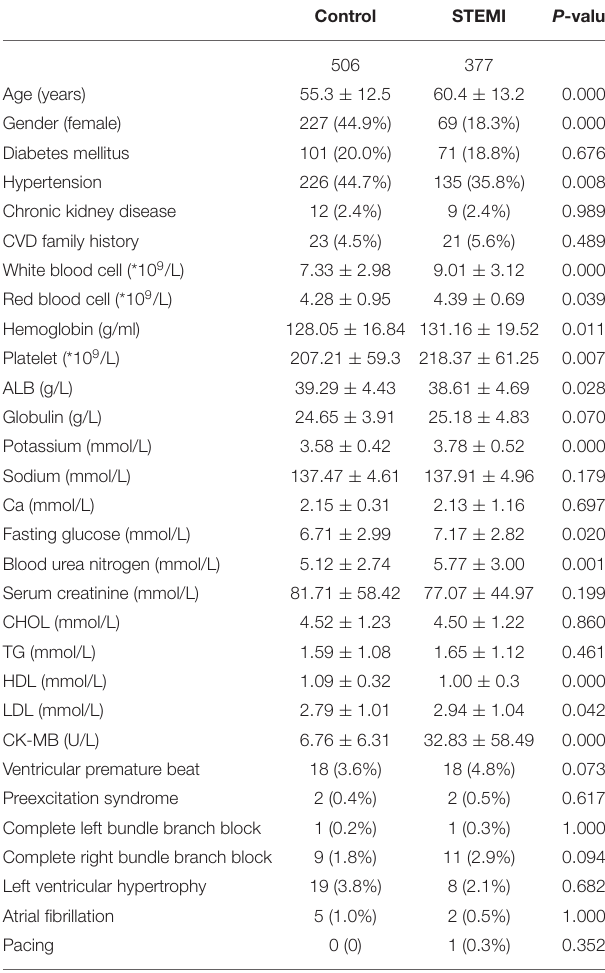
TABLE 1 | Baseline characteristics between patients with or without